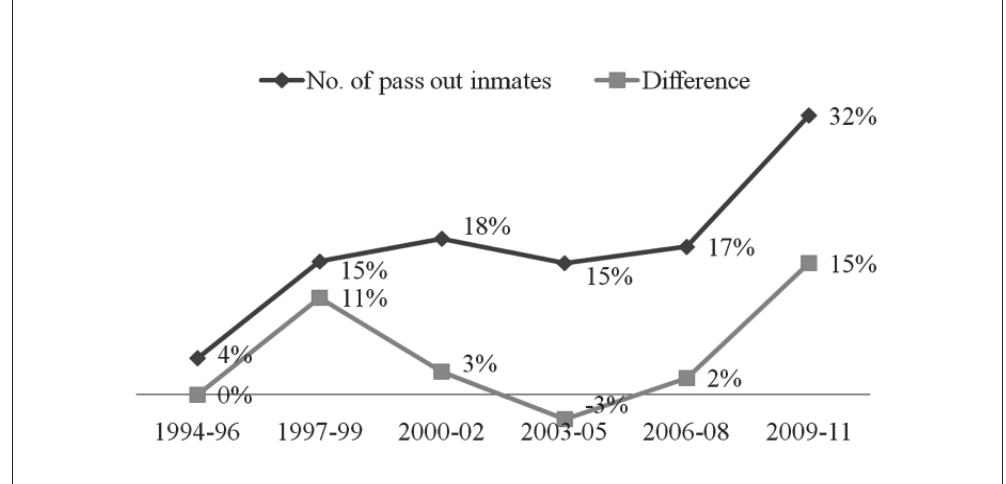
Figure 5 Percentage of students graduating each year Source: Tihar Study